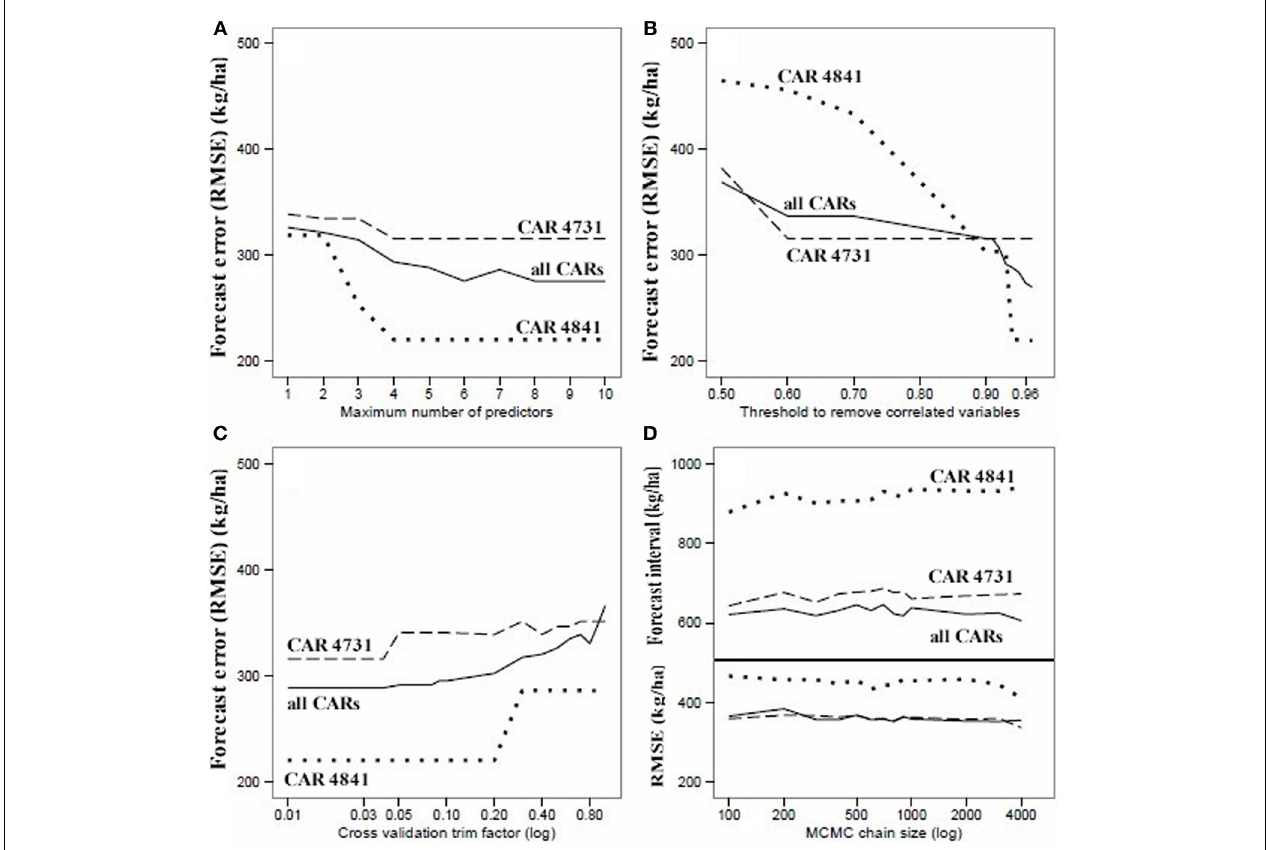
FIGURE 4 | Sensitivity of forecasted error in yield (RMSE, kg/ha) ( y -axes) to leading model design parameters ( x -axes). The solid line, dotted, and dashed lines track the median yield across: all CARs, CAR 4841 (low sensitivity case), and CAR 4731 (high sensitivity case), respectively, for: (A) maximum number of predictors (trim factor to 0.04 and number of predictors varies from 1to10), (B) CORRtrimfactor (i.e., thresholdfor removing correlated variables), with the maximum number of predictors set to 5, (C) CV trim factor (i.e., a parameter of the lmrob() R library algorithm of the robustbase package that is a percentage for the upper percentile of observations to drop based on their